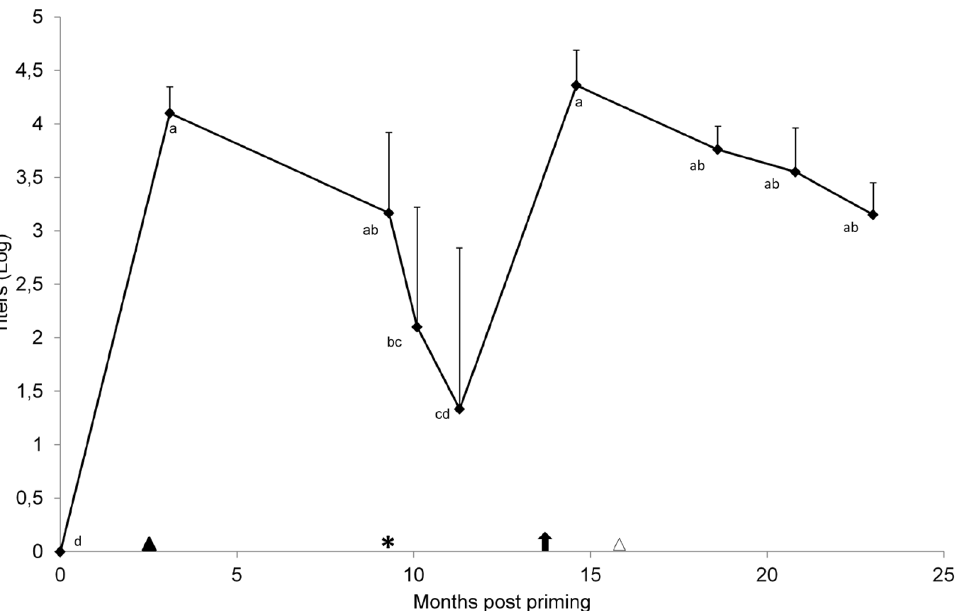
Figure 1. Monitoring of anti-AFB 1 Ab titers. Mean anti-AFB 1 Ab titers of high responder cows (n=6) following vaccination with AnAFB 1 -KLH in complete (first dose) and incomplete (3 boosters at three weeks intervals) Freund’s adjuvant. Two animals were removed from treated group (at 13.8 and 20.8 months post priming, respectively) for health injuries unrelated to vaccination. Partum was at an average of 9.6 6 0.75 months after first dose vaccine administration. Data are presented (on a logarithmic scale) as mean and SD. m , fourth dose of vaccine (2.1 months); , booster (13.8 months); , partum (9.6 6 0.75 months); n , AFB 1 administration (15.6 months). Titers corresponding to points with different subscripts (a, b, c, d) differ significantly as post-hoc evaluation by Tukey’s test (P , 0.05).